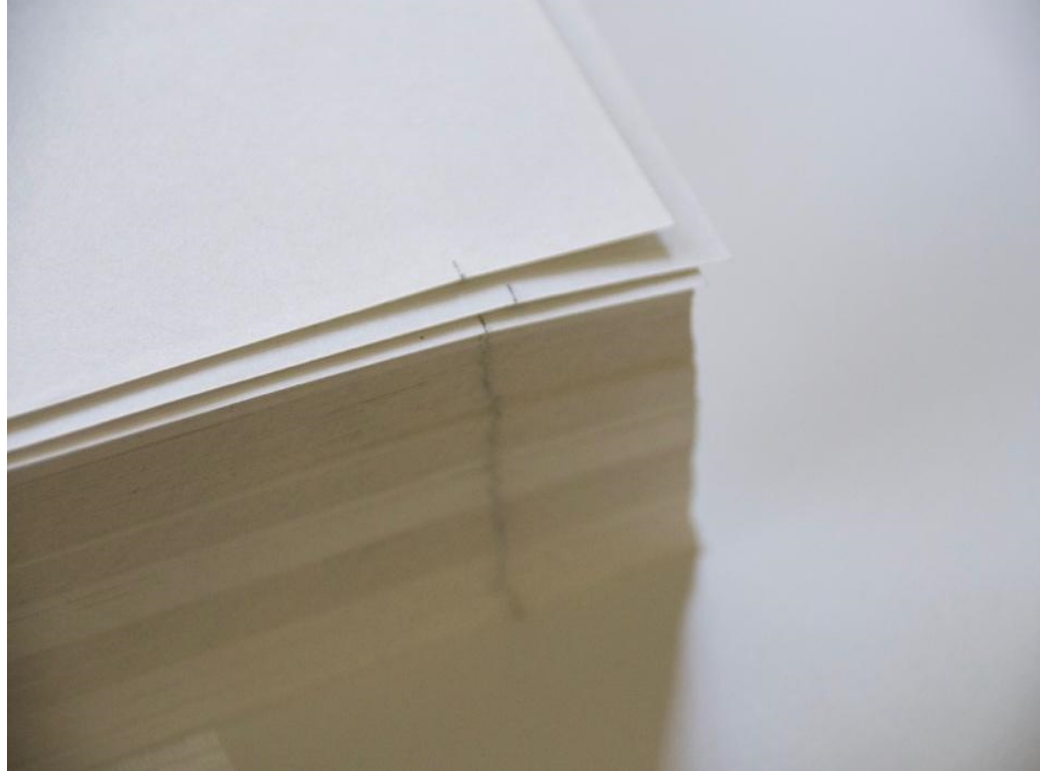
Figure 8. The days we’ve been together , 2018. Detail. Typewriter marks on paper, dimensions variable. Collection of the artist. Collection of the